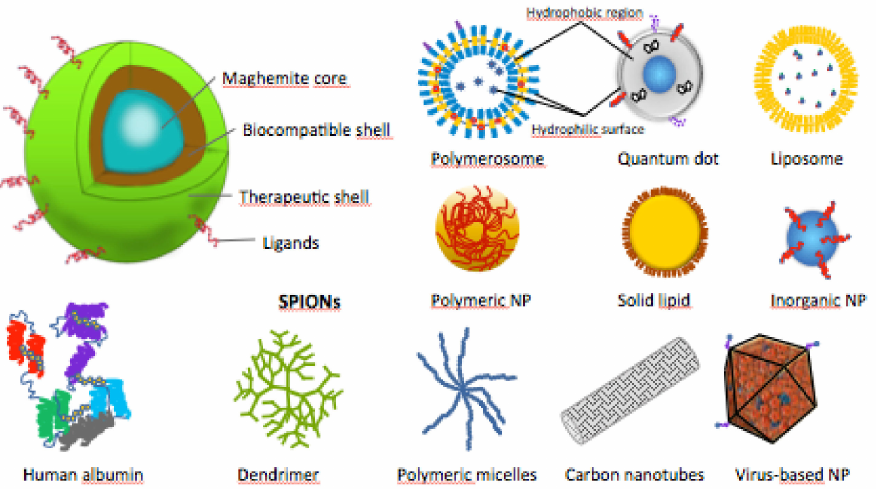
Figure 4. Schematic structures of SPIONs and other types of therapeutic nanoparticles